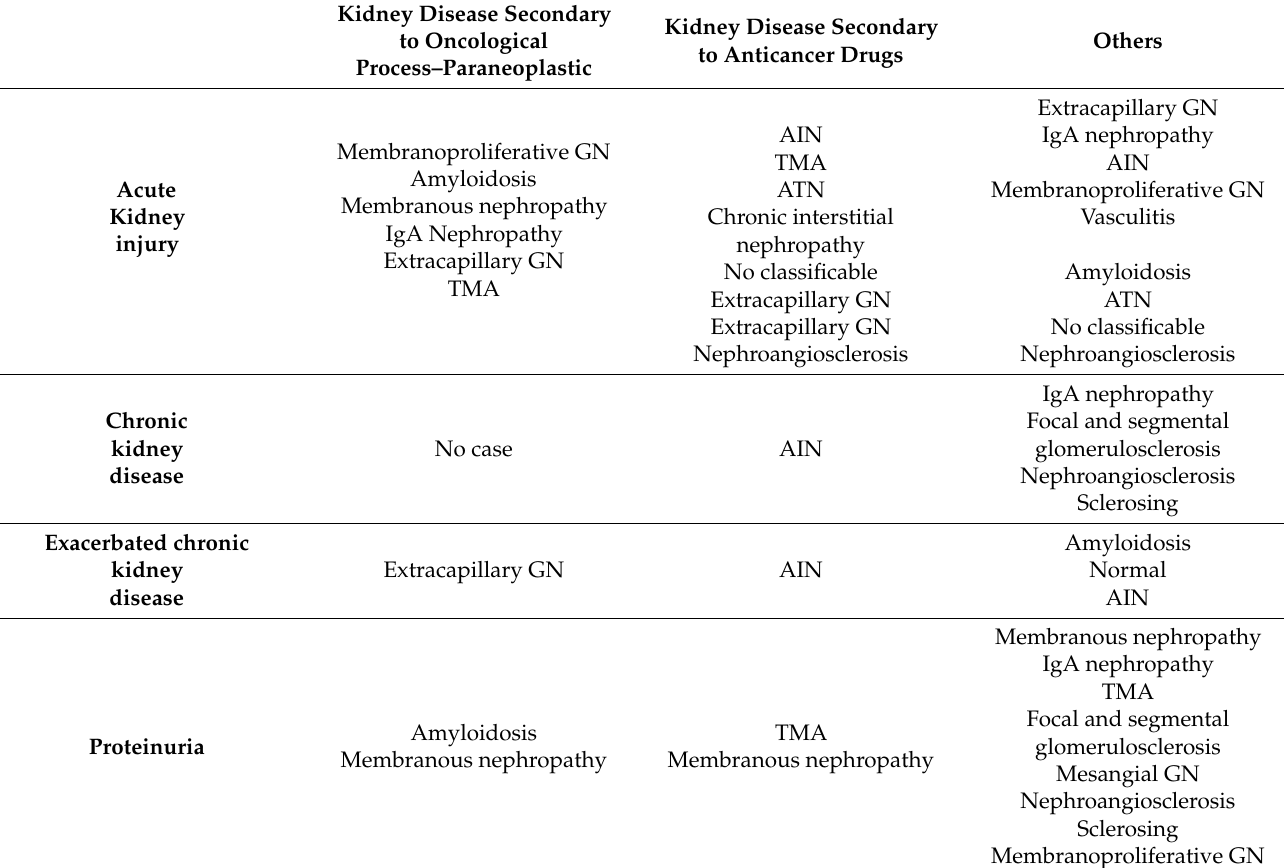
Table 4. Kidney disease associated with cancer patients.